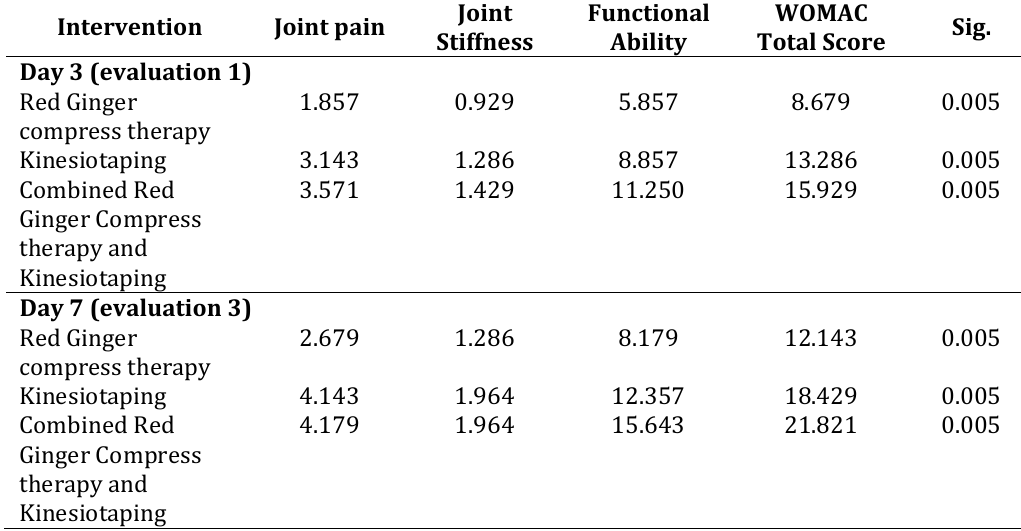
Comparison of Effectiveness of Red ginger Compress Therapy, Kinesiotaping, and Combined Red Ginger Compress Therapy and Kinesiotaping towards joint pain, joint stiffness, Functional Ability and WOMAC Total